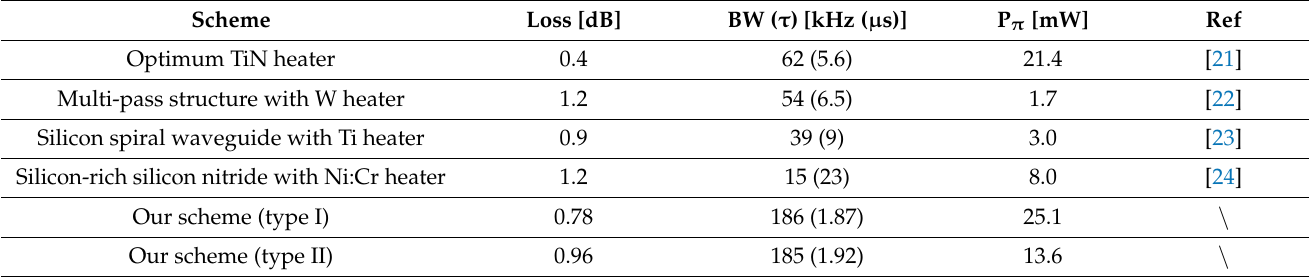
Table 1. Comparison of experimental results with phase shifters using metallic